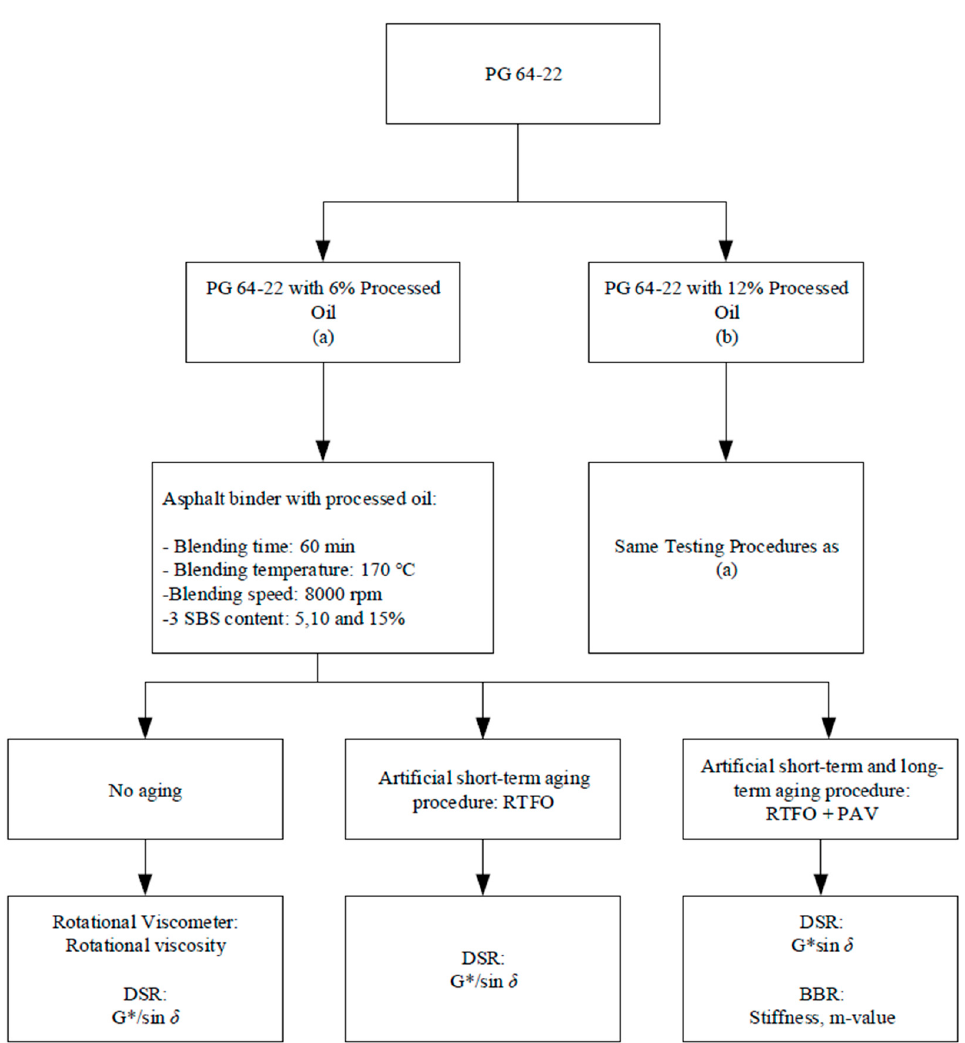
Figure 1. Flow chart of experimental design procedures.